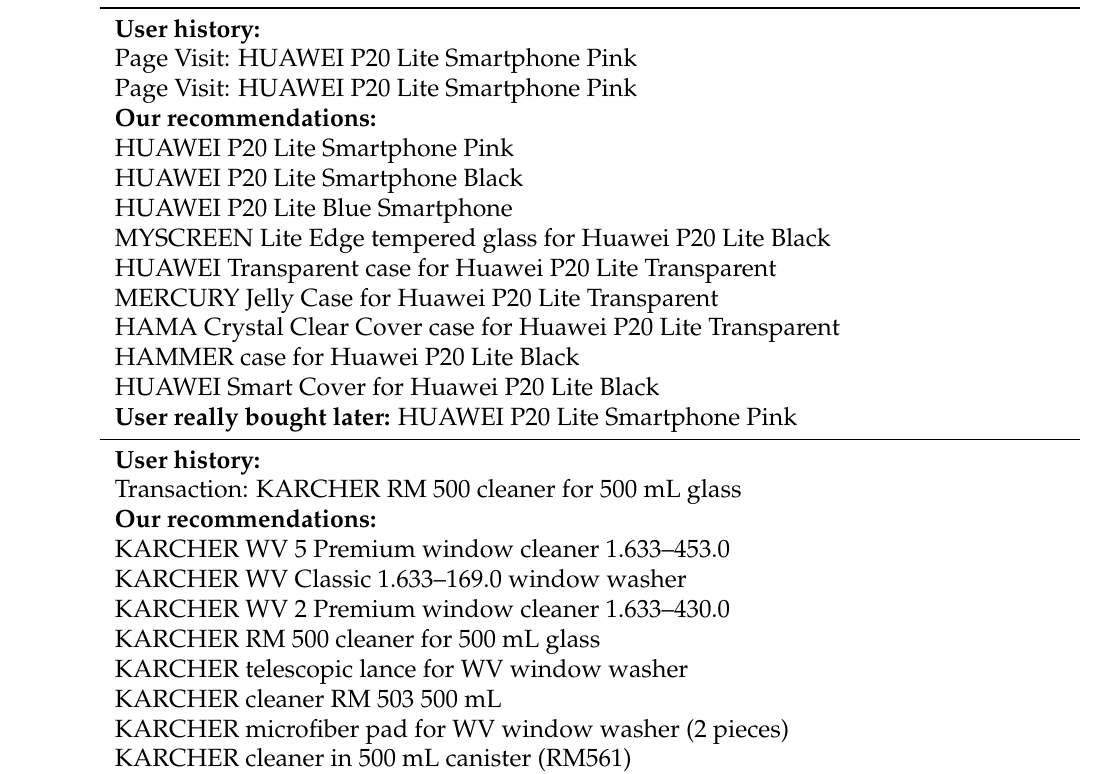
Table 4. Examples of recommendations for our personalised recommenders in electronic products. We can also see complementary products that fit very well to the viewed